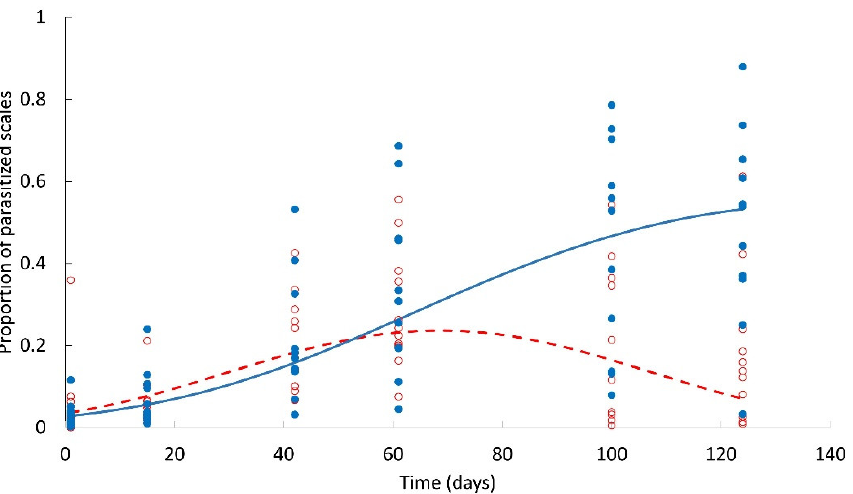
Figure 4. Proportion of scales of stages 2 and 3 parasitized by Mexidalgus toumeyellus throughout the life cycle of Toumeyella martinezae , in presence and absence of its mutualistic ant Liometopum apiculatum . Blue solid circles correspond to the treatment without ants and empty red circles to the treatment with ants. The solid blue line corresponds to the model adjusted for the treatment without ants and the dotted red line with the presence of ants.